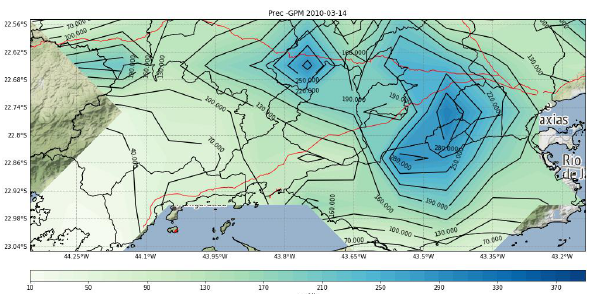
Figure 7. Accumulated daily rainfall on shaded and black contour lines with red lines representing pipeline transmissions. Date